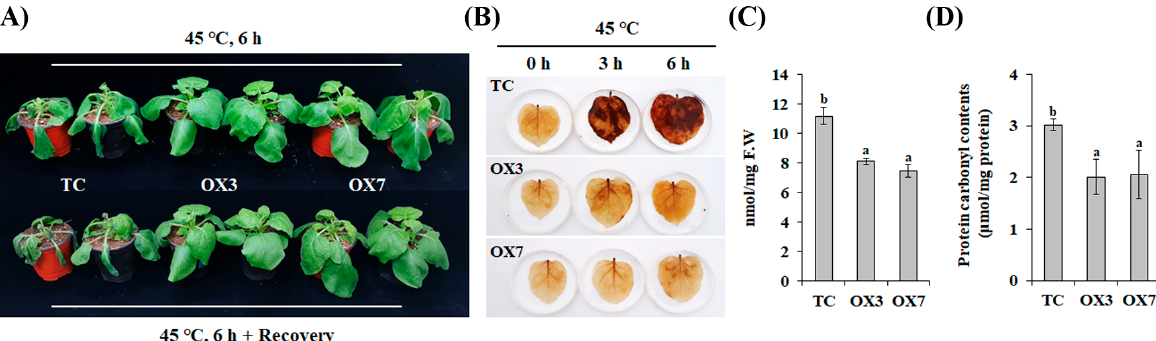
Figure 5. BrbZIP-S overexpression improved heat tolerance in N . benthamiana plants. ( A ) The phenotype of BrbZIP-S- overexpressing plants (OX3 and OX7 lines) and transgenic control (TC) plants after exposure to 45 °C for six hours and recovery overnight at normal growth conditions. Changes in H 2 O 2 level ( B ), malondialdehyde (MDA) level ( C ), and protein carbonyl content ( D ) were determined. Means (±SE) with different letters are significantly different (Duncan’s multiple range test, p < 0.05).